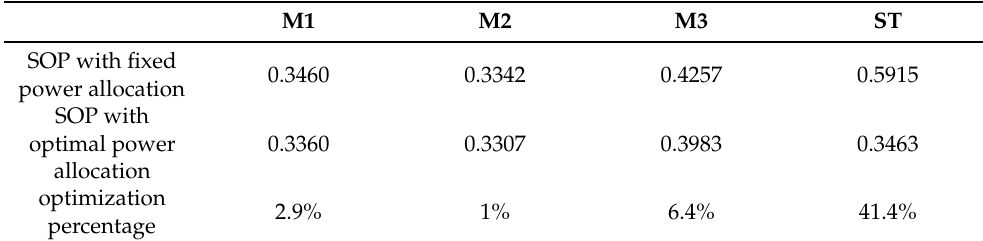
Table 2. Comparison of optimized secrecy outage